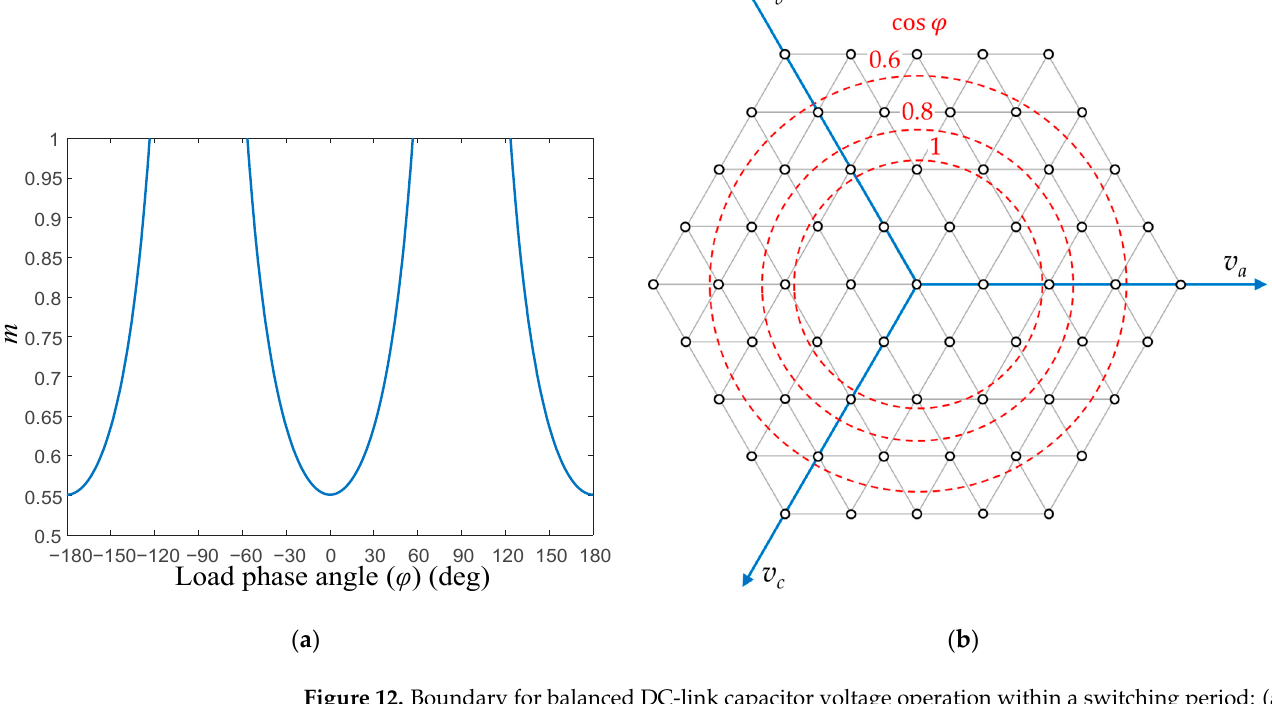
Figure 12. Boundary for balanced DC-link capacitor voltage operation within a switching period: ( a ) maximum modulation index depending on the load phase angle; ( b ) maximum modulation index depending on the load phase angle, over a space vector diagram of a 5-level three-phase converter.